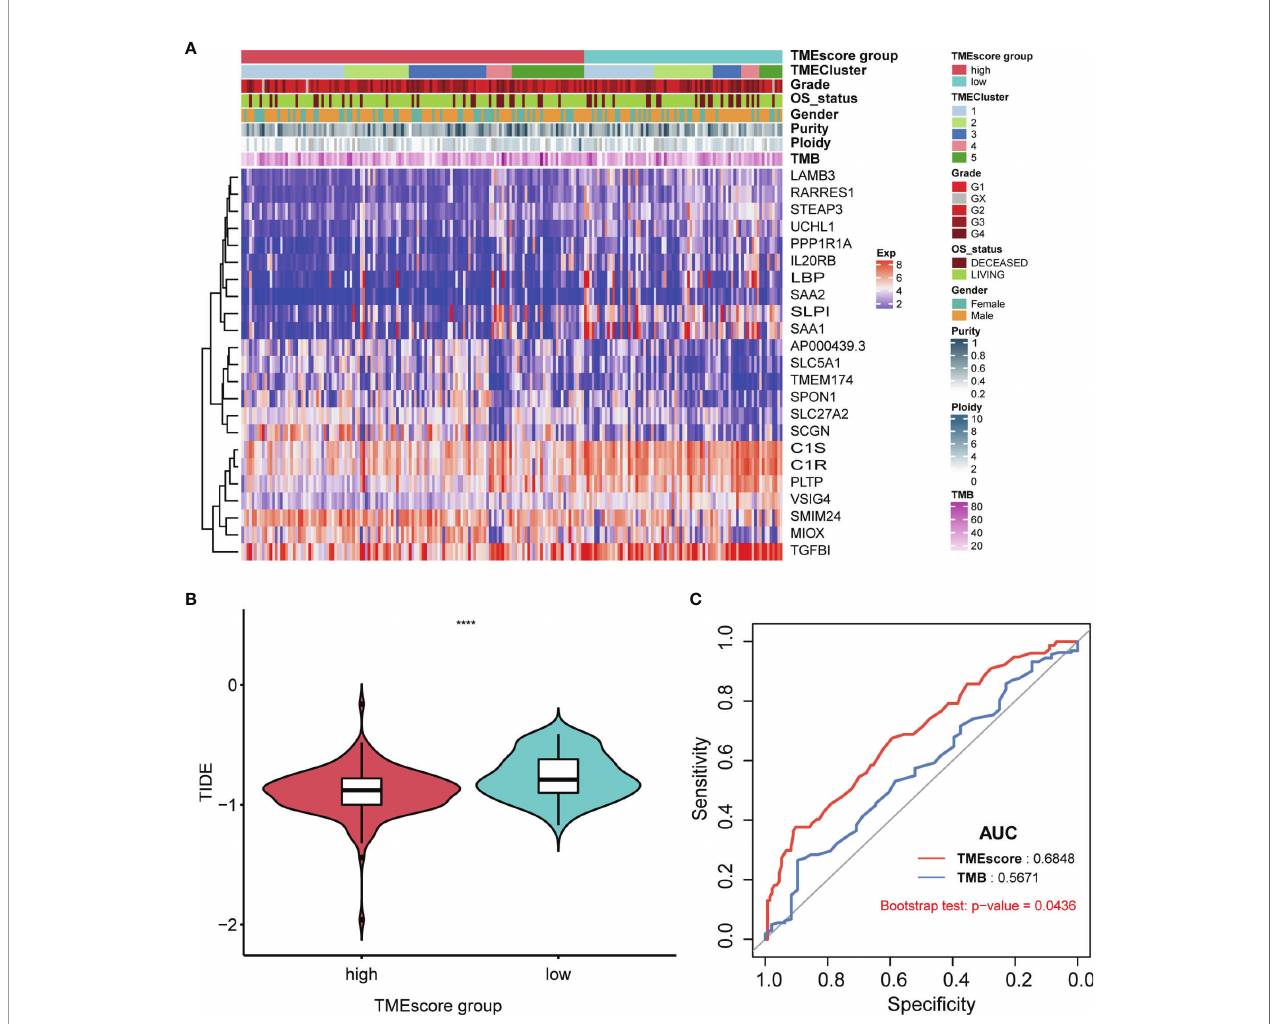
FIGURE 8 | Systematic exhibition of TMEscore with other variables and associations with ICB ef fi ciency compared with TMB. (A) Illustration of comprehensive genomic landscape integrating TMEcluster, TMEscores, mutation features (purity, ploidy, TMB) and clinical characteristics (age, gender, overall status). (B) In the current analysis, we found that KIRC patients with higher TME-scores might bene fi t from better ICBs ef fi ciency and optimistic prognosis. (C) Compared with traditional indicator of TMB, TMEscore possess the more predictive sensitivity based on the ROC curve with